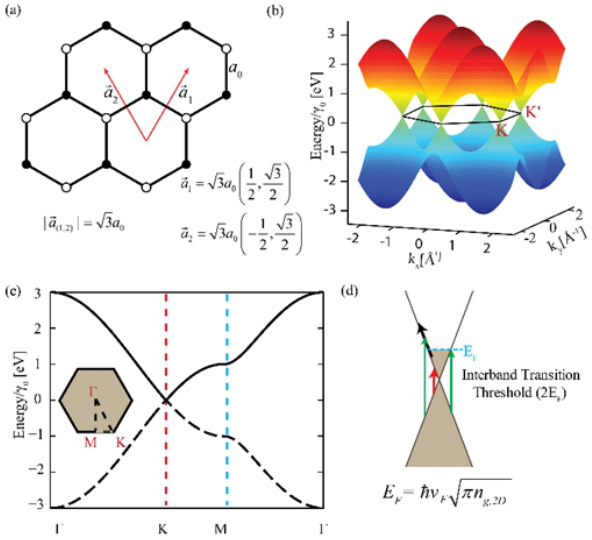
Figure 1: Electronic band structure of graphene: (a) Unit cell in re- ciprocal space showing the basis vectors ⃗ a 1 and ⃗ a 2 in terms of real spacelatticeconstant a 0 .(b)TheE-Kdiagramforgraphene(eq.1)cal- culated using the tight binding approximation. The conduction and valence bands meet at the six corners of the hexagon in reciprocal space (known as Dirac or K points). The energy scale is normalized to